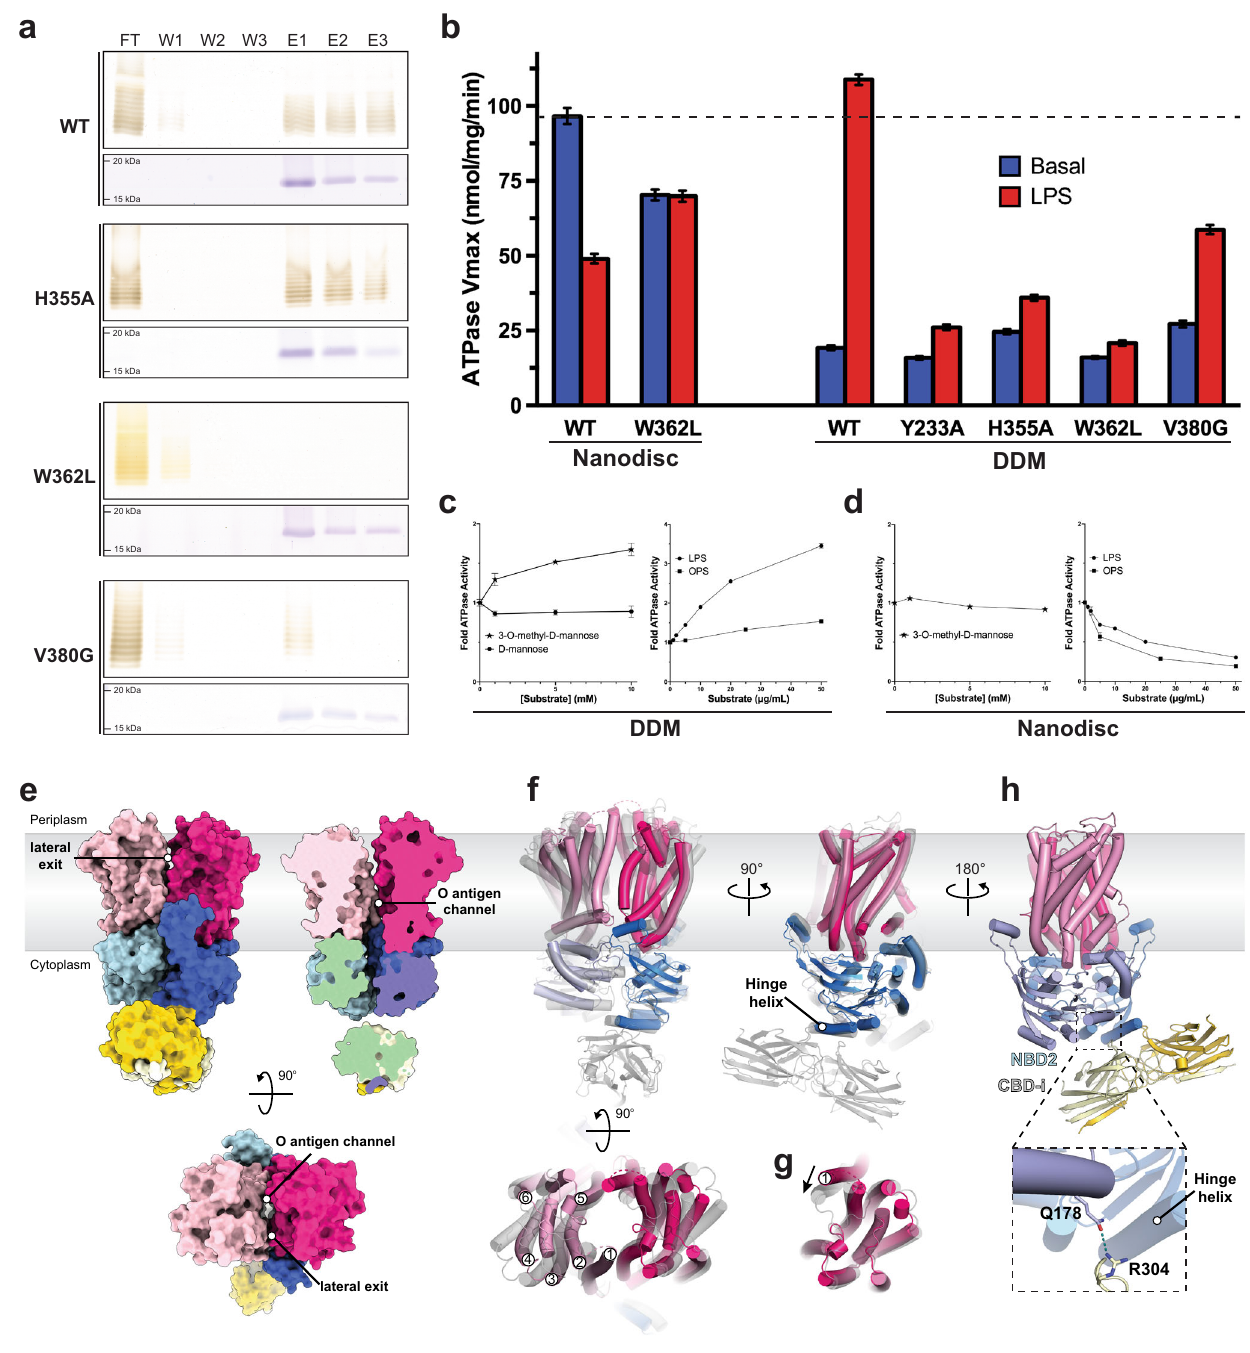
Fig. 6 | Site-directed mutagenesis disrupts LPS binding and O antigen modu- latedATPaseactivity.a SDS-PAGEofpulldownexperimentsexamining A.aeolicus LPS binding against different CBD mutant constructs. Top and bottom panels are silver and Coomassie-blue stained gels, respectively. Uncropped images are pro- vided as Source Data. b ATP hydrolytic activity of WzmWzt and O antigen binding mutants determined in nanodiscs and DDM micelle. WzmWzt ATPase activity measuring the maximum velocity among DDM-solubilized transporter and nano- discreconstitutedconstructsinthepresence(LPS)orabsence(Basal)ofsaturating A. aeolicus LPS. Data presents the maximum velocity measured from Michaelis Mentennon-linear fi tmodel.Eachdatapointisthemeansfrom3technicalrepeats. Errorbarsrepresenttheupperandlower95%con fi